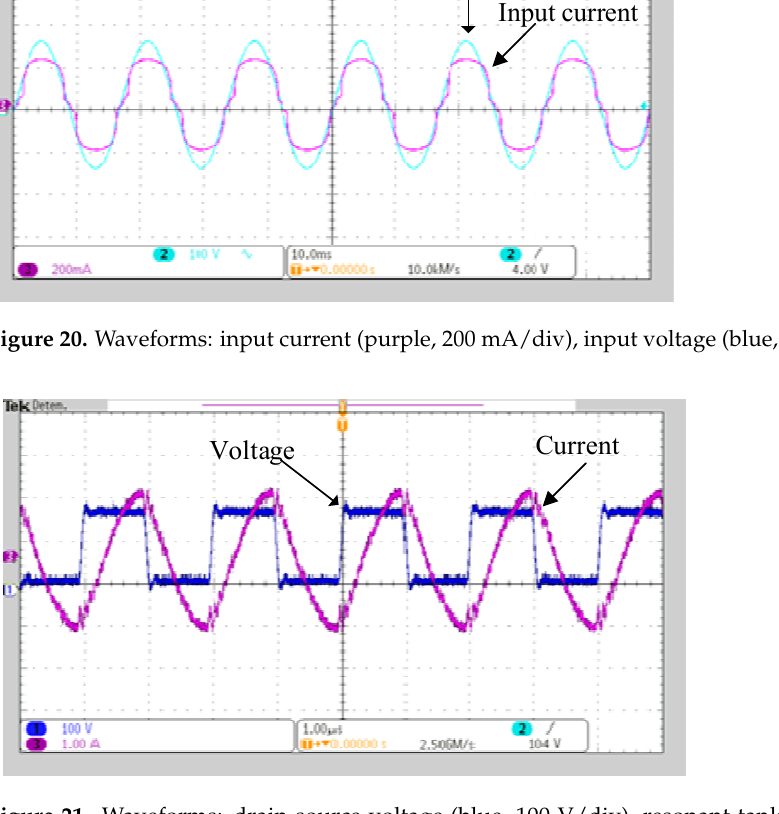
Figure 21. Waveforms: drain-source voltage (blue, 100 V/div), resonant tank current (purple, 1 A/div).